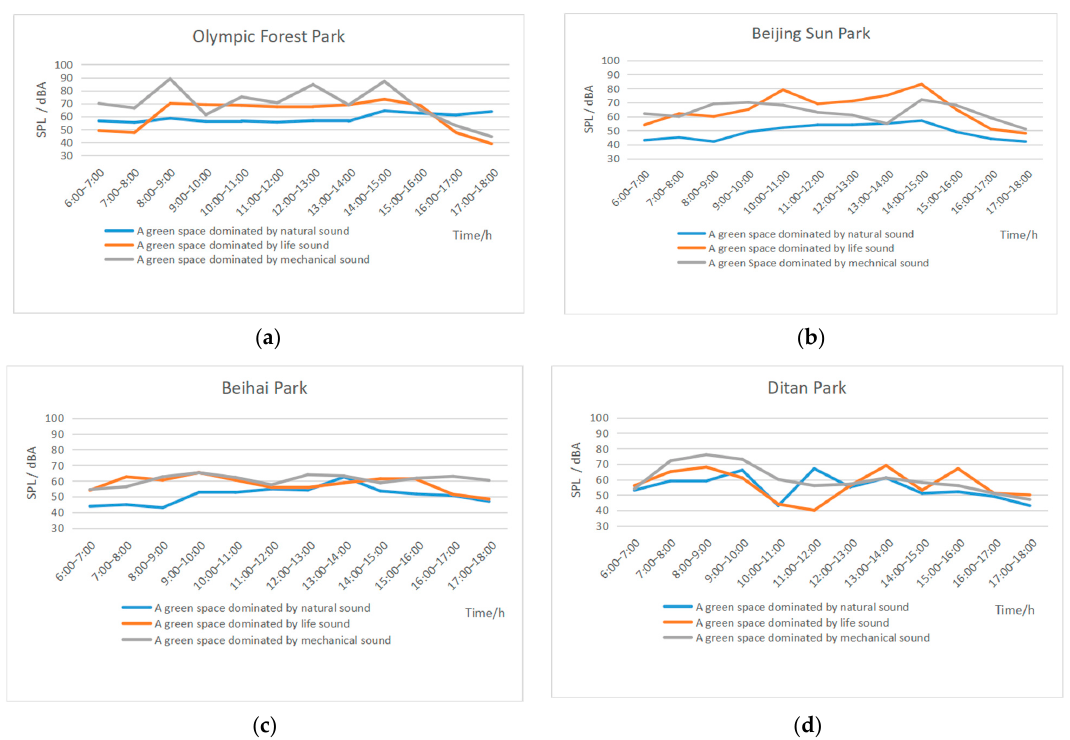
Figure 4. Trend diagram of sound pressure level in different time periods of various types of soundscape green spaces in four parks in winter. ( a ) Olympic Forest Park; ( b ) Beijing Sun Park; ( c ) Beihai Park; ( d ) Ditan Park. Notice: SPL represents Sound Pressure Level. Combined with the trend diagrams of the sound pressure levels in different periods of various types of soundscape green spaces in parks in summer and winter, it can be seen that the sound pressure level of green spaces dominated by natural sound changes less throughout the day. Contrastingly, the sound pressure level of green spaces is over- whelmed by life and mechanical sound. These changes were relatively significant. The trend of change in the two seasons is roughly the same. Nonetheless, the range of change of the sound pressure level in the park in summer is smaller than that in winter, which may be because the wind speed changes significantly in different periods of winter in Beijing, resulting in a more significant impact on the measurement. Compared with the same park, the sound pressure level of the green space dominated by natural sound in summer can reach the same level as that in winter. This is because although there is a blessing of wind in winter, the creatures in the green space in summer are more active, such as cicada chirping, which may continue to produce an influence. 4.1.2. Citizens’ Perception of the Soundscape Based on the trend of change in sound pressure levels of green spaces dominated by different soundscape in urban parks, this study used loudness and frequency perception to discuss citizens’ perceptions of different types of soundscape. This study uses a 5-point Likert scale to calculate loudness perception (1–5 points for ‘very low–very high’, 3 repre- sents neither too high or too low), frequency perception (1–5 points for ‘very little–very much’, 3 represents neither too much or too little), and the results are shown in Table 3. Table 3. The results of citizens’ perception of soundscape. Sound Types